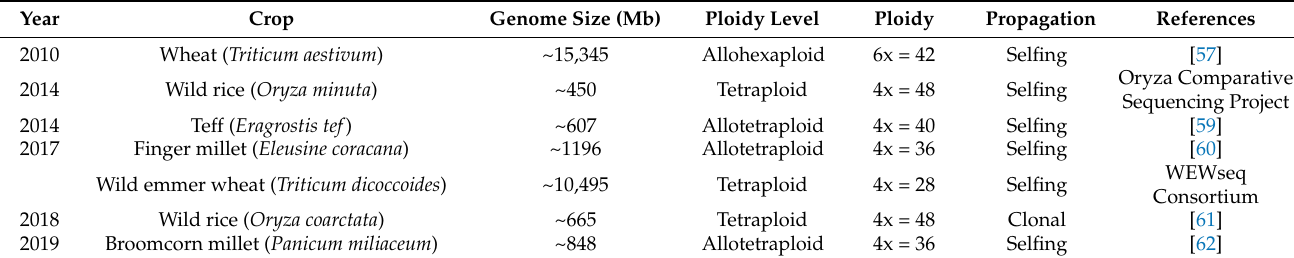
Table 1. Sequenced polyploid genomes of grasses (Poaceae) since